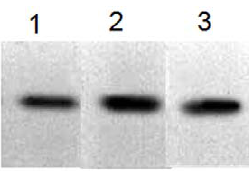
Figure 4. Gel washing with different types of water. BSA (500 ng) was separated by SDS-PAGE, and the separated gels were washed with different types of water: running water (Lane 1), distilled water (Lane 2), and double-distilled water (Lane 3) and stained with water-soluble CBBR solution at boiling temperature for 60 s.